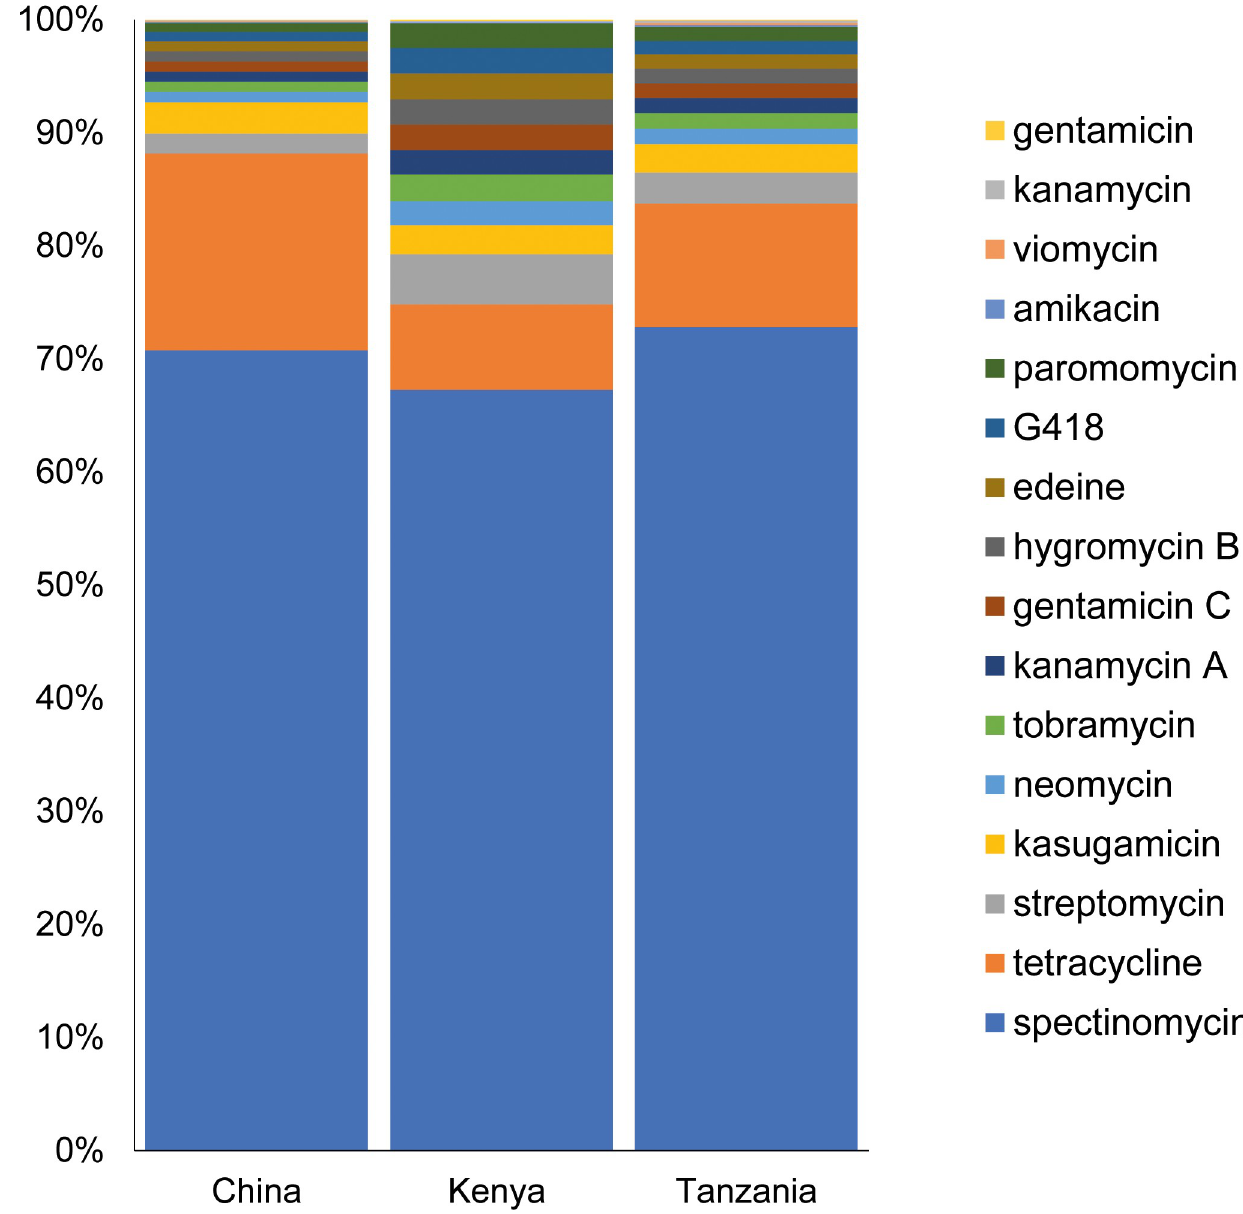
Fig 6. Relative abundance of genes for resistance to antibiotics identified in the microbiome of Diaphorina citri from China, Kenya and Tanzania.